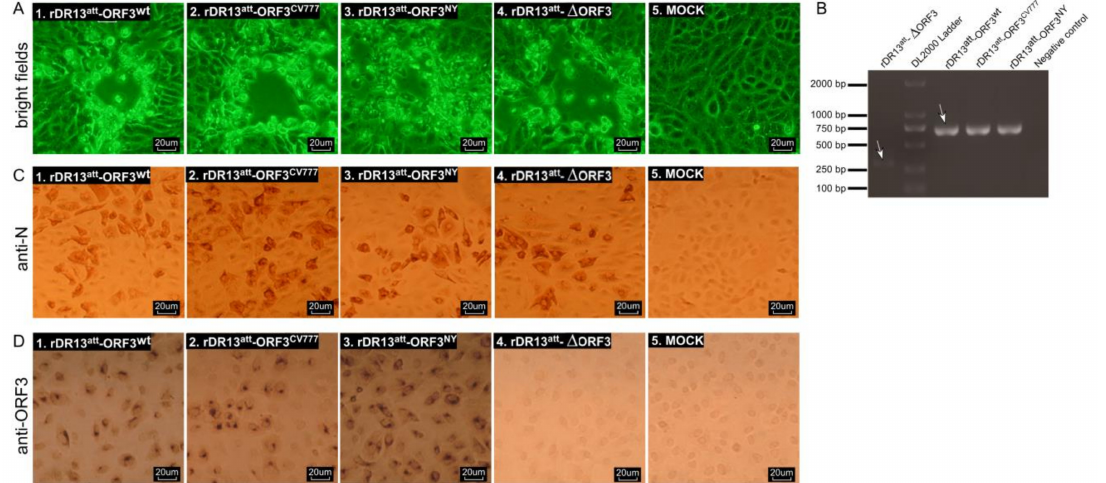
Figure 2. Characterization of recombinant PEDVs. ( A ). Cytopathic e ff ect (CPE) induced by rPEDVs